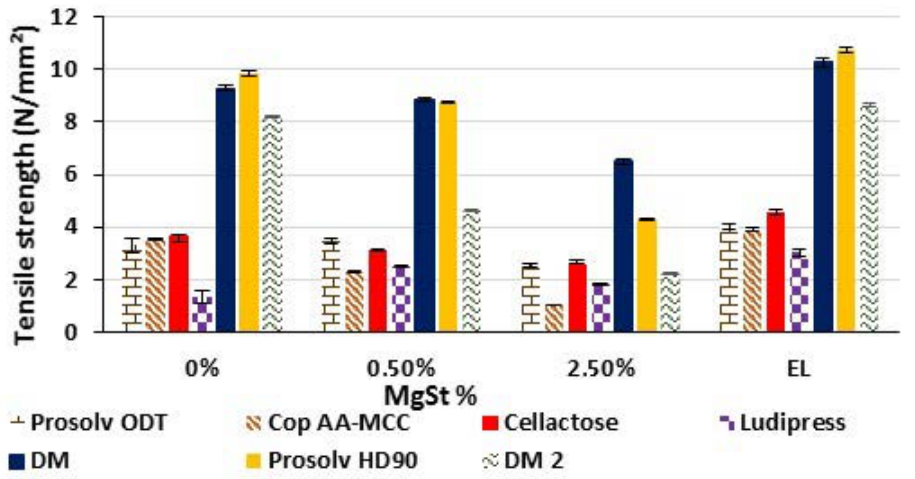
Figure 7. Effect of internal lubricant concentration and external lubrication (EL) on tablet tensile strength of the different studied materials.